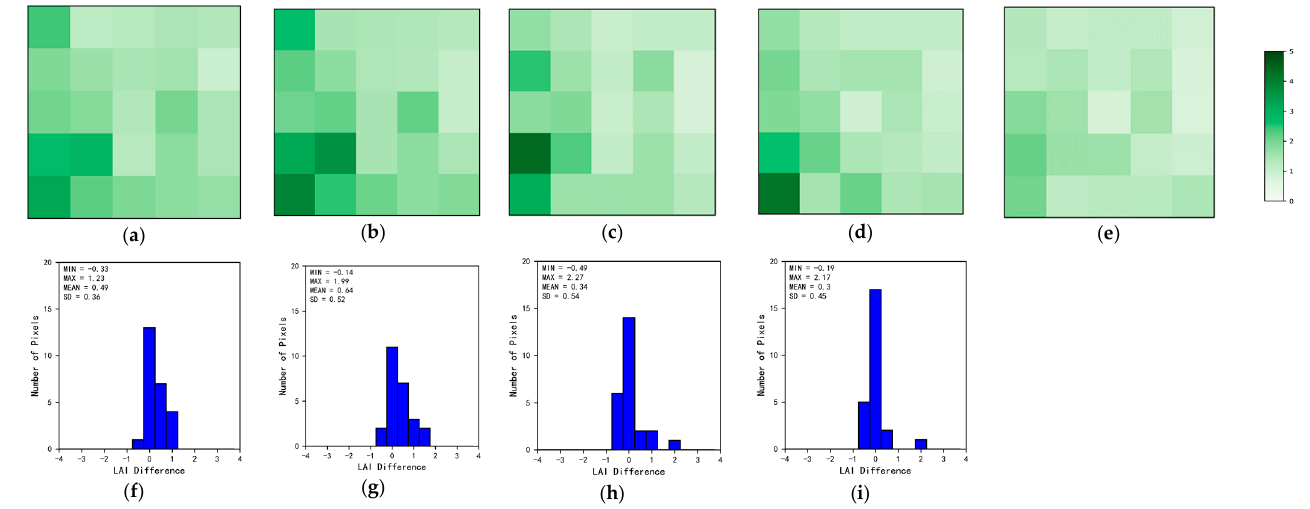
Figure 10. Images of the LAI-TCA ( a ), the LAI-GRNN ( b ), the VIIRS ( c ), the MODIS ( d ) and the LAI values acquired from high-resolution reference maps ( e ) at the Peyrousse site on Day 174, 2015. ( f – i ) Statistical distributions of discrepancies between the LAI-TCA, the LAI-GRNN, the VIIRS, the MODIS and the LAI values acquired from high-resolution reference maps.